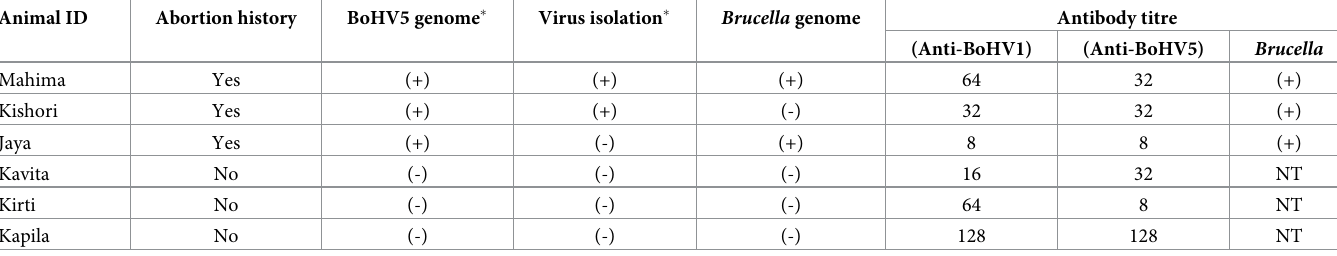
Table 2. Virus isolation, detection of viral genome and antiviral antibodies in aborted and apparently health animals. Animal